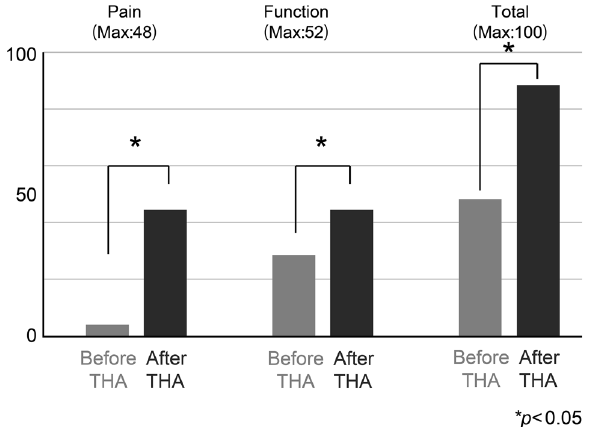
Figure 4. The change of the score of total mHHS, pain, and function. The total mHHS, pain score, and function score were significantly improved after THA. mHHS modified Harris Hip Score, THA total hip arthroplasty.